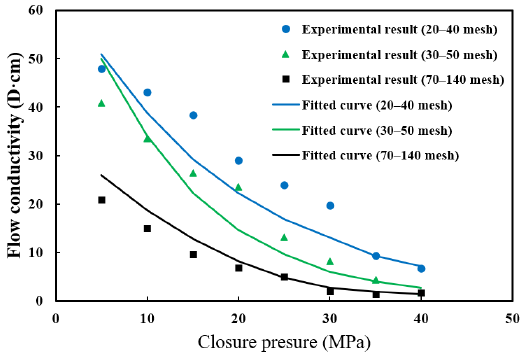
Figure 3. Experimental results and fitting results of conductivity under different closing pressures.